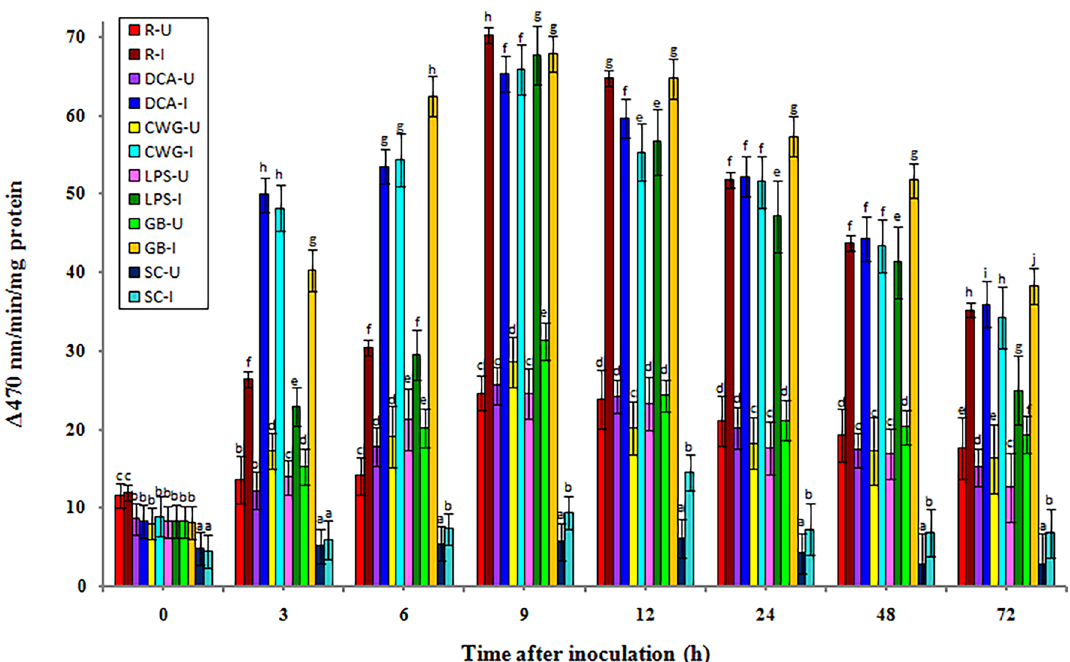
Figure 2. Temporal pattern of POX activity in 2-day old P. glaucum seedlings with (I-inoculated) or without (U-uninoculated) Sclerospora graminicola inoculation. R-resistant, S-susceptible, DCA-3,5-Dichloroanthranilic acid treated, CWG—Cell Wall Glucans isolated from the endophyte Trichoderma hamatum UOM 13, LPS— Lipopolysaccharides isolated from bacteria Pseudomonas fluorescens UOM 14, GB—Glycinebetaine an amino acid derivative. Bars indicate standard errors; means with different superscripts are significantly different, as shown by Tukey’s HSD test ( p ≤